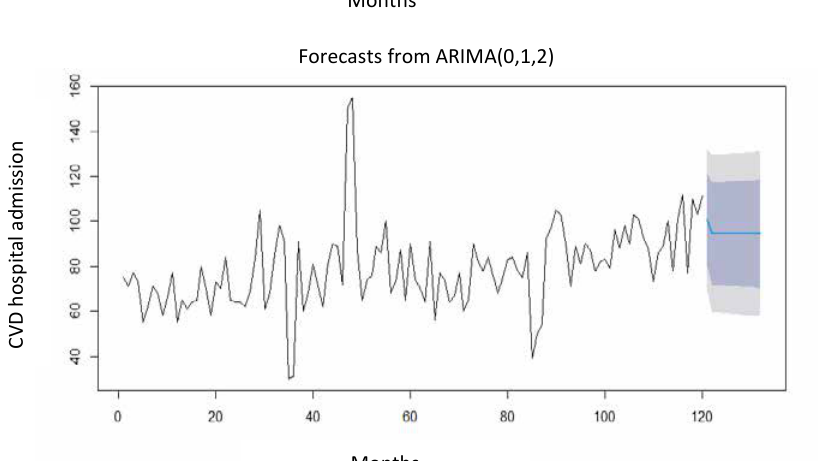
Fig. 4: Prediction forecast of cardiovascular hospital admission in Sabah with air pollutants as regressor in